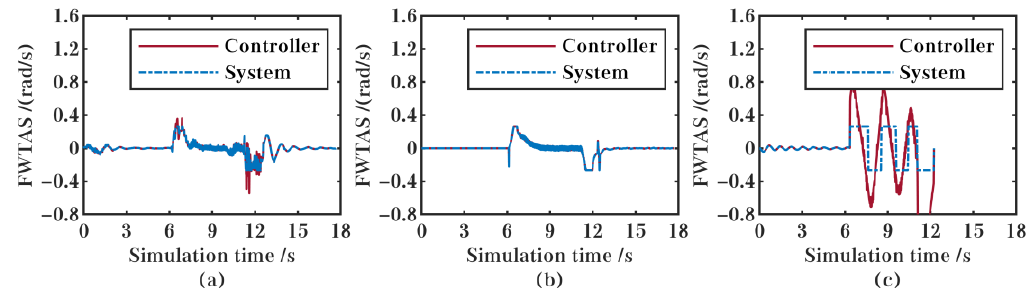
Figure 7. The front wheel turning angle speed of the comparison simulation: ( a ) the NN controller; ( b ) the NMPC controller; ( c ) the Stanley controller.